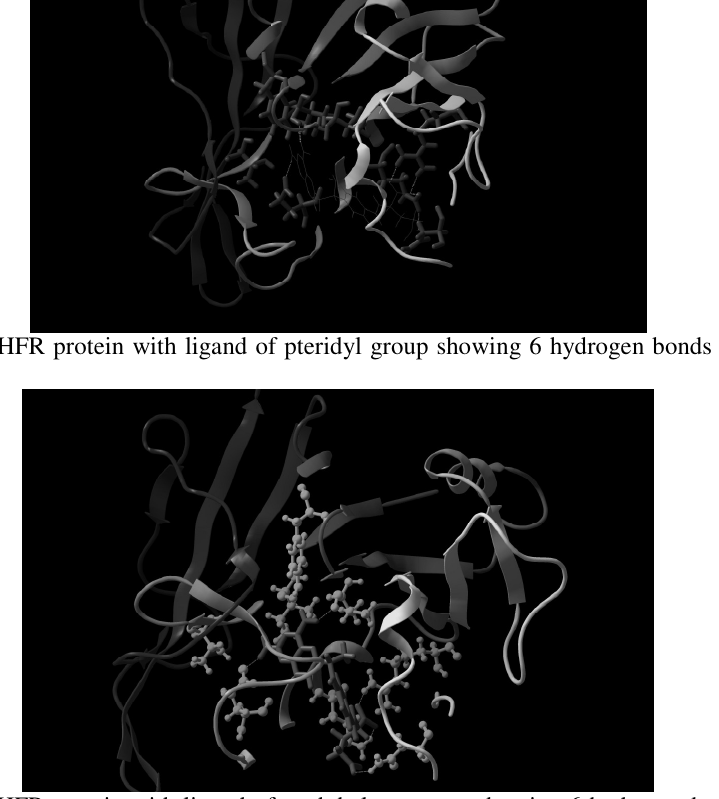
Figure 4. DHFR protein with ligand of naphthalene group showing 6 hydrogen bonds with the active